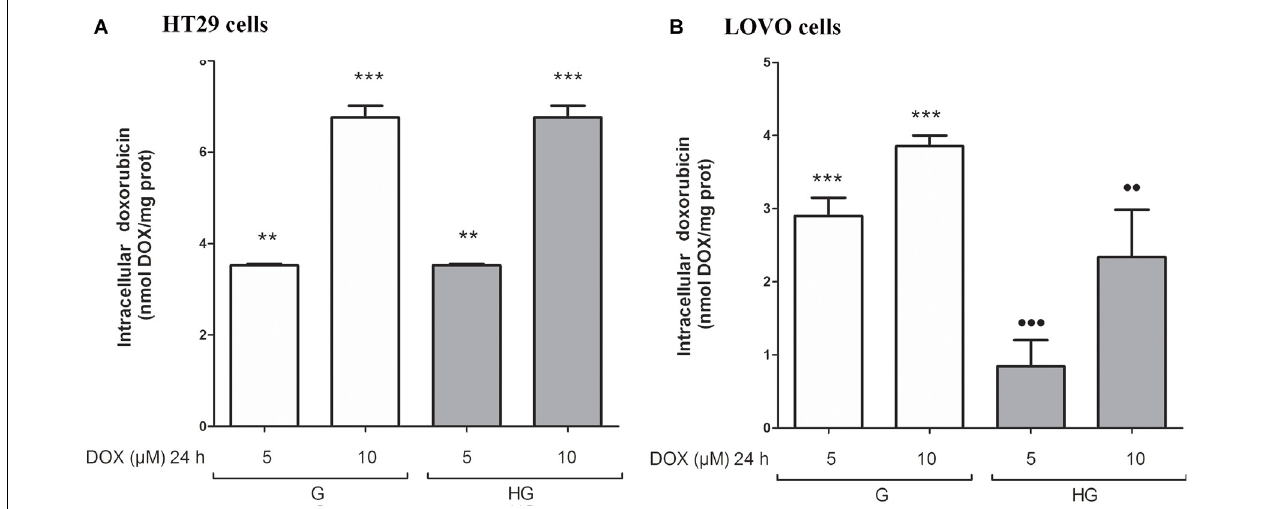
FIGURE 5 | Effect of normal glucose (G) and high glucose (HG) on intracellular accumulation of DOX in human colon cancer (HT29 and LOVO) cells. Cells were cultured for ≥ 7 days in the presence of G and HG and incubated with 5 and 10 µ M DOX for 24 h before analysis (A,B) . The measurements were performed in triplicate ( n = 6). ∗∗ p < 0.001 5 µ M DOX in HT29 cells cultured in G and in HG vs. 0 µ M DOX in HT29 cells cultured in G and in HG; ∗∗∗ p < 0.0001 10 µ M DOX in HT29 cells cultured in G and in HG vs. 0 µ M DOX in HT29/LOVO cells cultured in G and in HG; ∗∗∗ p < 0.0001 5 and 10 µ M DOX in HT29 cells cultured in G vs. 0